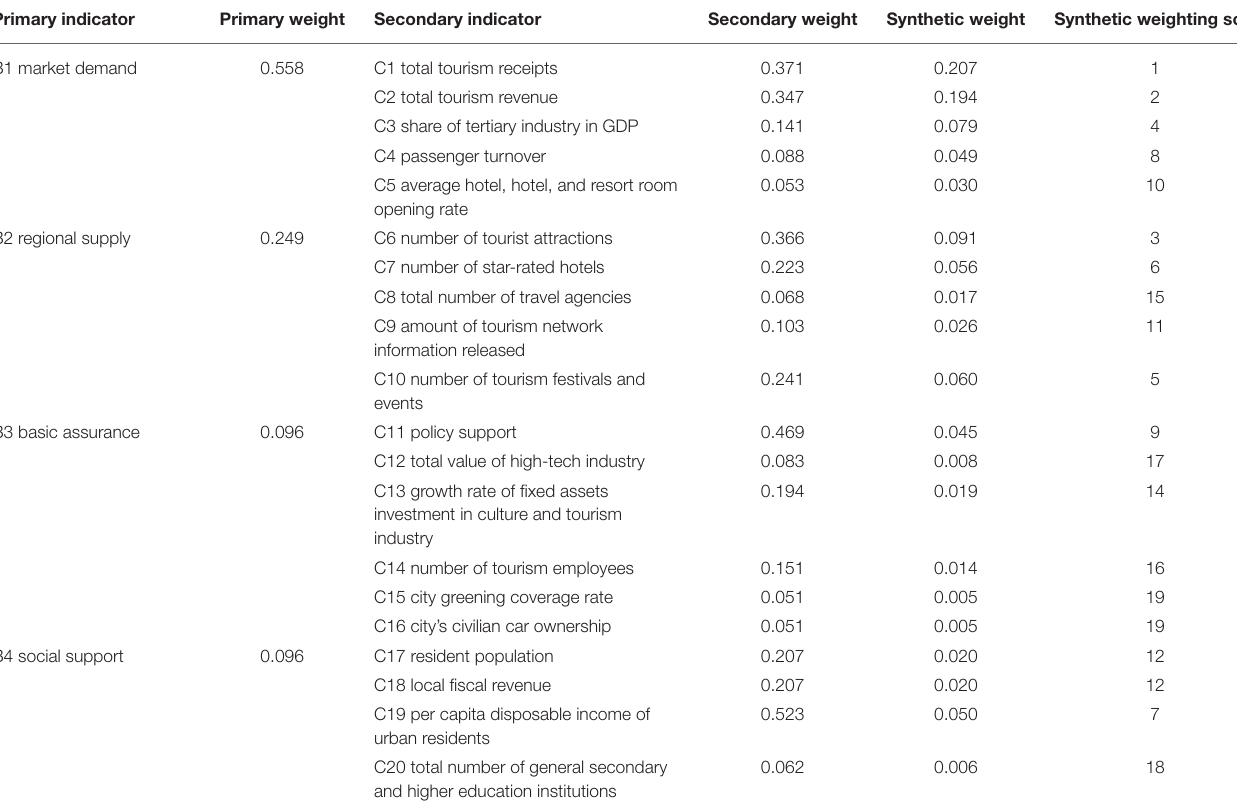
TABLE 3 | Summary of the weights of indicators at all levels of sustainable development evaluation of the tourism economy in Shenzhen.